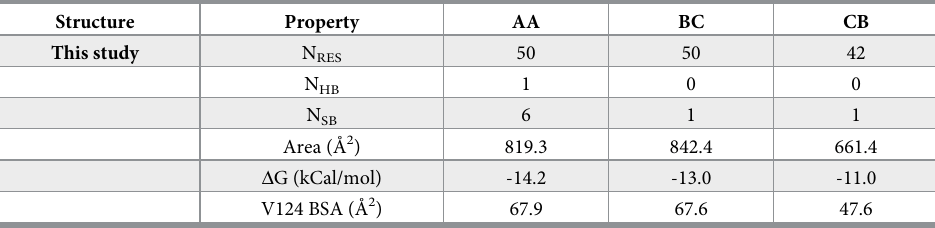
Table 4. PISA inter-dimer interface analysis of T = 3 capsids 1